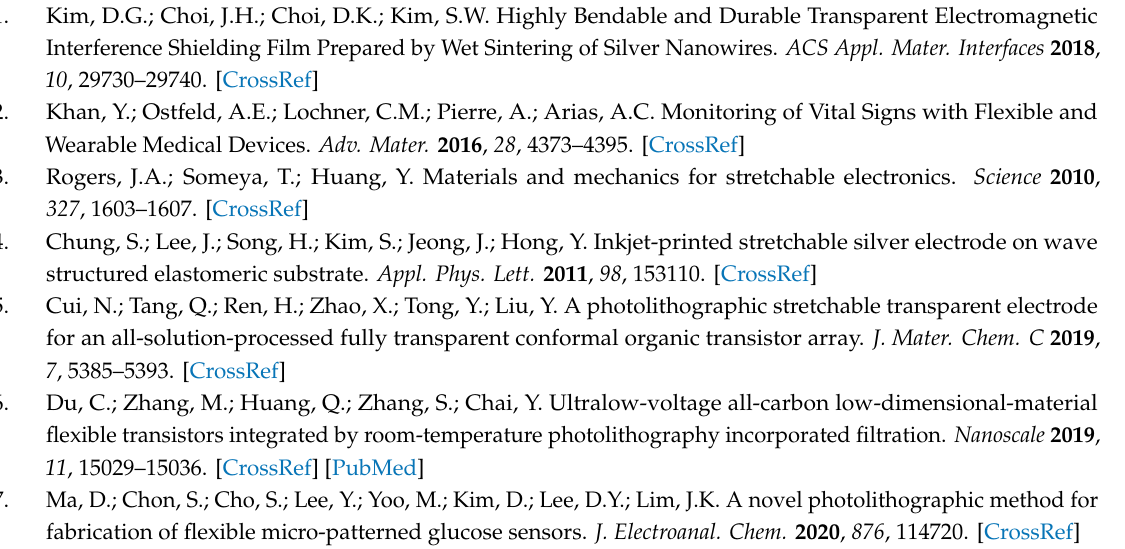
Figure S1. SEM image of Pt-coated PI film used as a substrate. Figure S2. Optical photo showing the experimental setup for measuring the bending durability and specific electrical resistance of silver electrodes fabricated according to the curing temperature; (a) before bending, (b) after bending. Figure S3. AFM images of silver electrodes fabricated at various curing temperatures; (a) 150 ◦ C, (b) 170 ◦ C, (c) 190 ◦ C. Figure S4. SEM images of silver electrode without the curing process; (a) Low-magnification, (b) High-magnification. Figure S5. XRD patterns of silver electrodes fabricated at various curing temperatures. Figure S6. EDX spectrum of the silver electrode at a 170 ◦ C curing temperature. Figure S7. Surface profile results close to the average value of silver electrodes fabricated at varying curing temperatures; (a) without curing process, (b) 150 ◦ C, (c) 170 ◦ C, (d) 190 ◦ C. Figure S8. Specific resistance of the silver electrode fabricated at varying curing temperatures. Table S1. The mean value and standard deviation of the profile analysis result of the silver electrode fabricated at varying curing